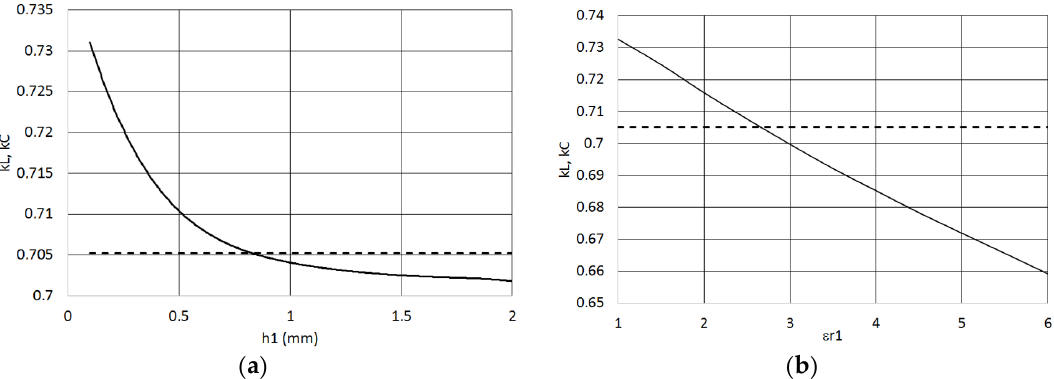
Figure 3. Calculated inductive k L (dashed lines) and capacitive k C (solid lines) coupling coefficients for the coupled line geometry in which the following parameters have been chosen: h 4 = 0.76 mm, r 4 = 4.5, h 3 = 0.09 mm, r 3 =3.38, h 2 = 0.05 mm, r 2 = 3.4, w 1 = 0.345 mm, s 1 = 1mm, w 2 = 0.315 mm, s 2 = 0.6. Analysis of the geometry vs. the thickness h 1 of the top layer assuming dielectric constant r 1 = 2.5,